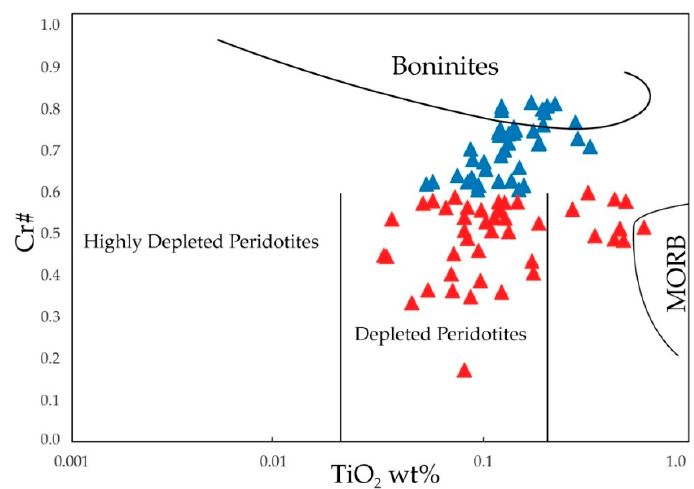
Figure 11. Compositional variations of chromian spinels from the Waropen Regency: ( A- on the left side) Cr# vs. Mg# chemical classification diagram (after [55]); ( B- on the right side) TiO 2 vs. Al 2 O 3 diagram (after [62]).